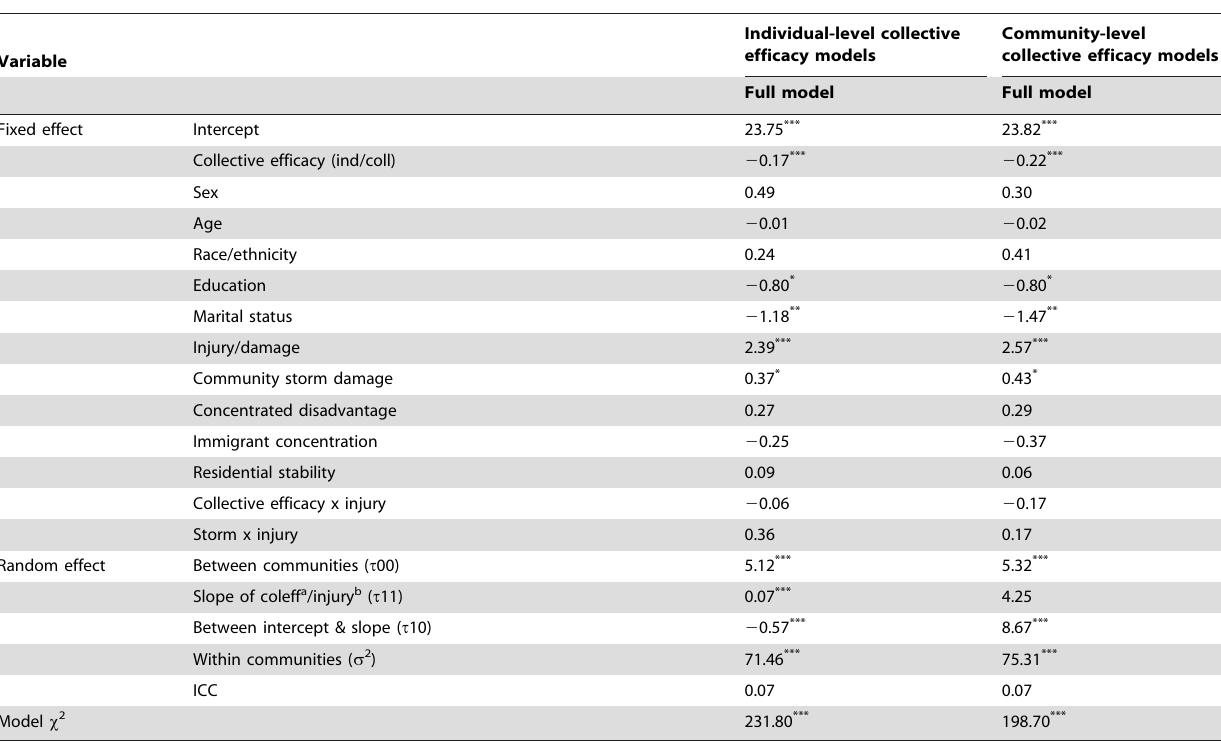
Table 3. Parameter estimates of two multilevel linear regression models on PTSD symptom severity (n=1880).